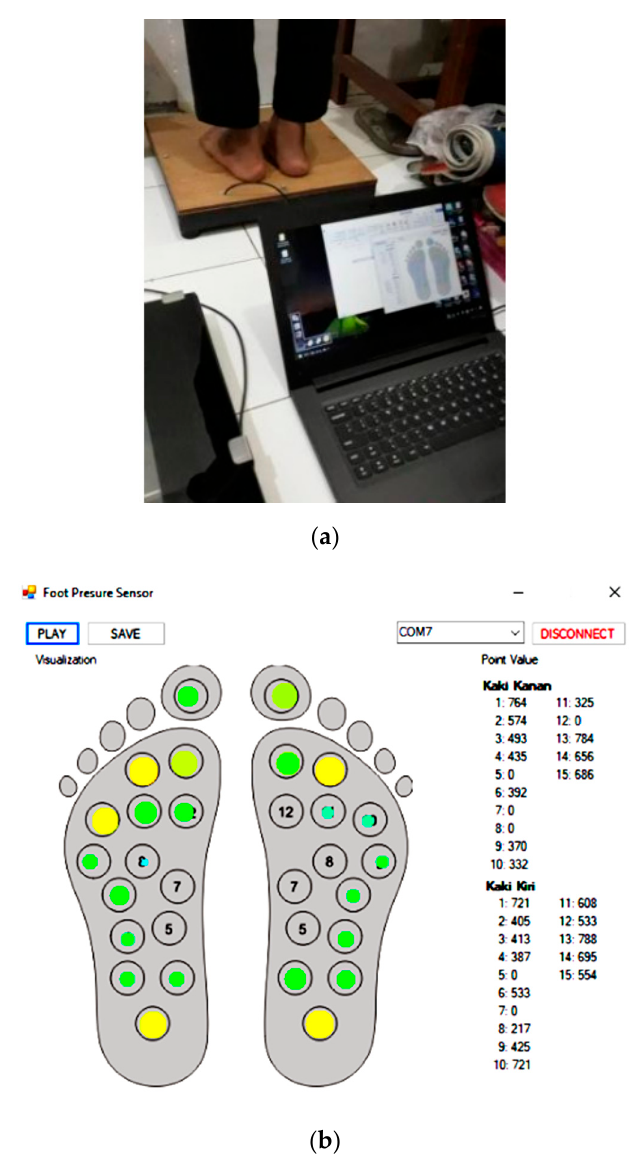
Figure 4. Method of measurements static load of foot ( a ) and display result ( b ). Note: Kaki Kanan (Right Foot) and Kaki Kiri (Left Foot).